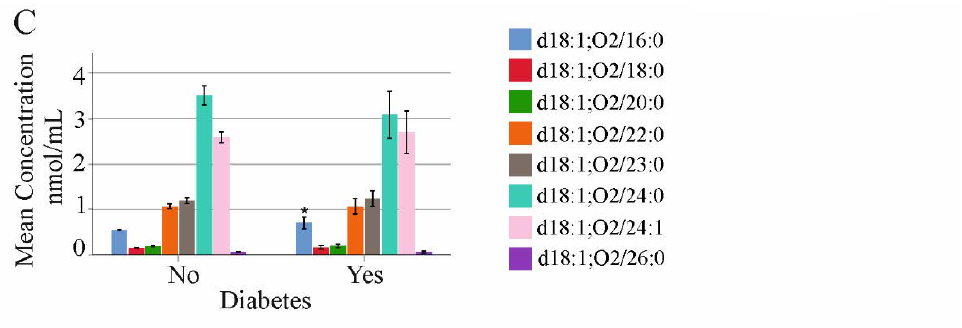
Figure 1. Ceramide species in relation to gender, fatty liver disease, and diabetes in patients with chronic HCV. ( A ) Ceramide species in 74 female and 104 male patients; ( B ) ceramide species in 104 patients without (No) and 74 patients with (Yes) fatty liver disease; ( C ) ceramide species in 154 patients without (No) and 20 patients with (Yes) diabetes. Mean concentration ± 95% confidence interval is shown. * p < 0.05. Table 2. Spearman correlation coefficients and p -values for the correlations of ceramide species with BMI, age, MELD score, viral load, and routine laboratory parameters in the HCV patients before direct-acting antiviral (DAA) therapy. Significance level was set to p < 0.05. Significant correlations are in bold (alanine amino transferase (ALT), aspartate aminotransferase (AST), body mass index (BMI), C-reactive protein (CRP), high-density lipoprotein (HDL), international normalized ratio (INR), low-density lipoprotein (LDL), model of end-stage liver disease (MELD), not significant (ns)).